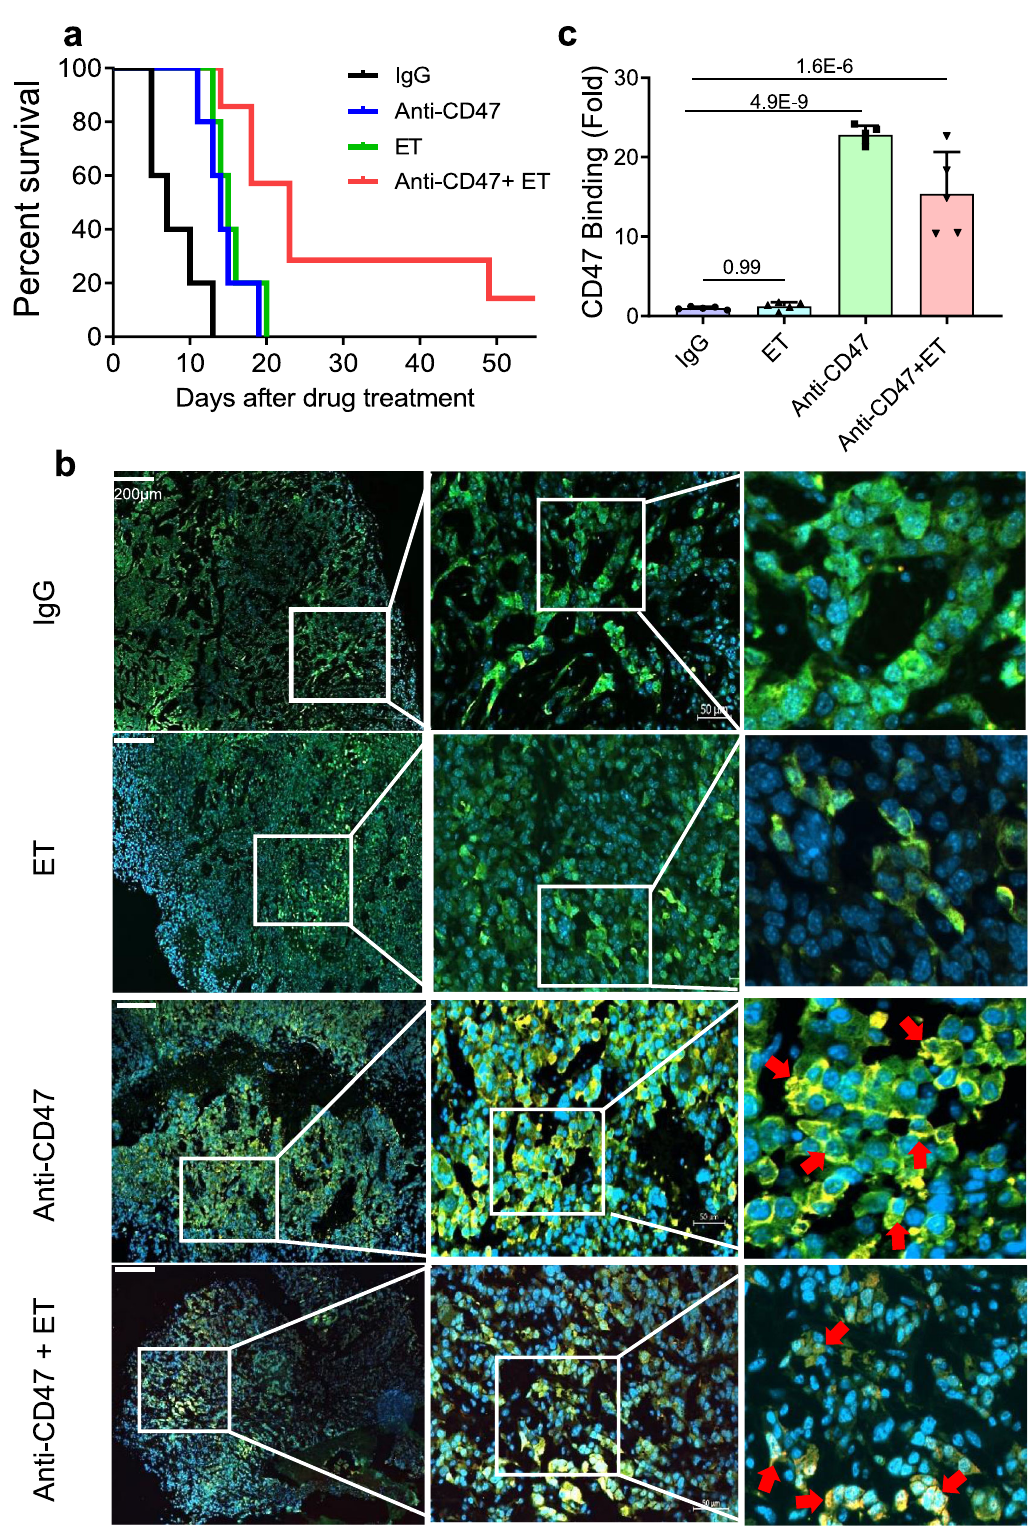
Fig. 7 Animal survival and anti-CD47 antibody tumor penetration in combined treatment. a Kaplan – Meier survival of mice of Fig. 6b. b Representative immuno fl uorescence images of in fi ltrated anti-CD47 antibody in GFP- labeled GL261 orthotopic tumors. Antibody tumor penetration and binding to the targeted receptor were identi fi ed by rabbit anti-rat IgG as primary antibody and Rhodamine Red-X-Conjugated goat anti-rabbit as the secondary antibody. The mouse anti-GFP antibody and Alexa 488 conjugated goat anti-mouse secondary antibody recognized GFP expressing GL261 tumor cells. The binding of the anti-CD47 antibody on tumor cells is indicated with red arrows (green, tumor cells; yellow, rabbit anti-rat CD47 antibody bind to CD47 presenting tumor cells; blue, nucleus stained with DAPI). c Antibody binding density of control and treated tumors was estimated by Image-Pro Plus 6.0 ( n = 5). Results represent means ± SD; ANOVA one-way test was applied. Source data are provided as a Source Data fi